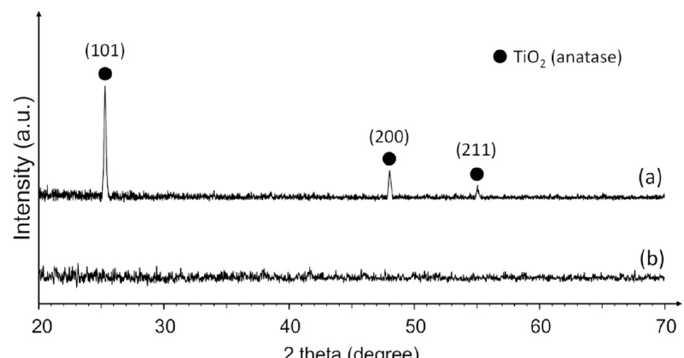
Figure 2. XRD pattern of (a) crystalline and (b) amorphous carbon-doped TiO 2 films deposited on the surface of HDPE beads using 300 W and 260 W magnetron power,